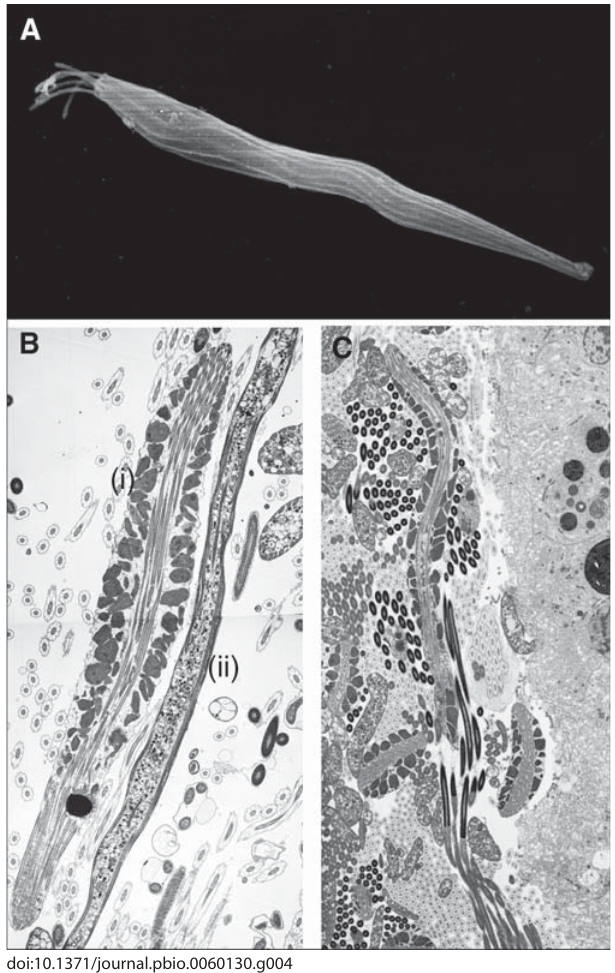
Figure 4. Mollusc